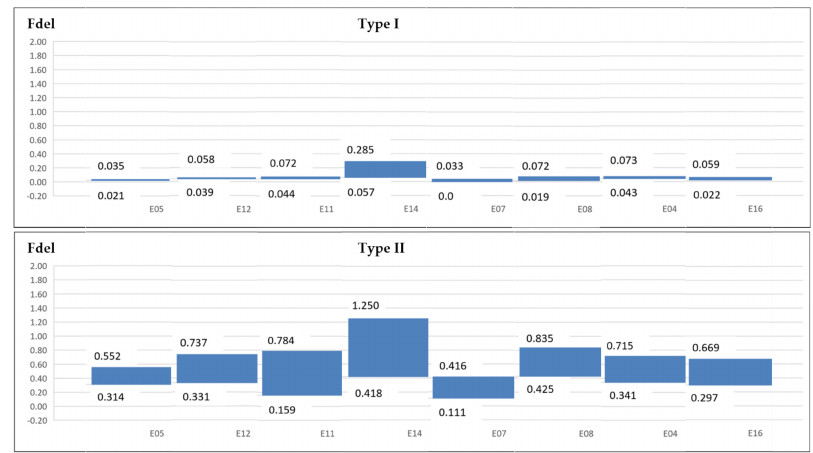
Figure 11. Fdel delamination